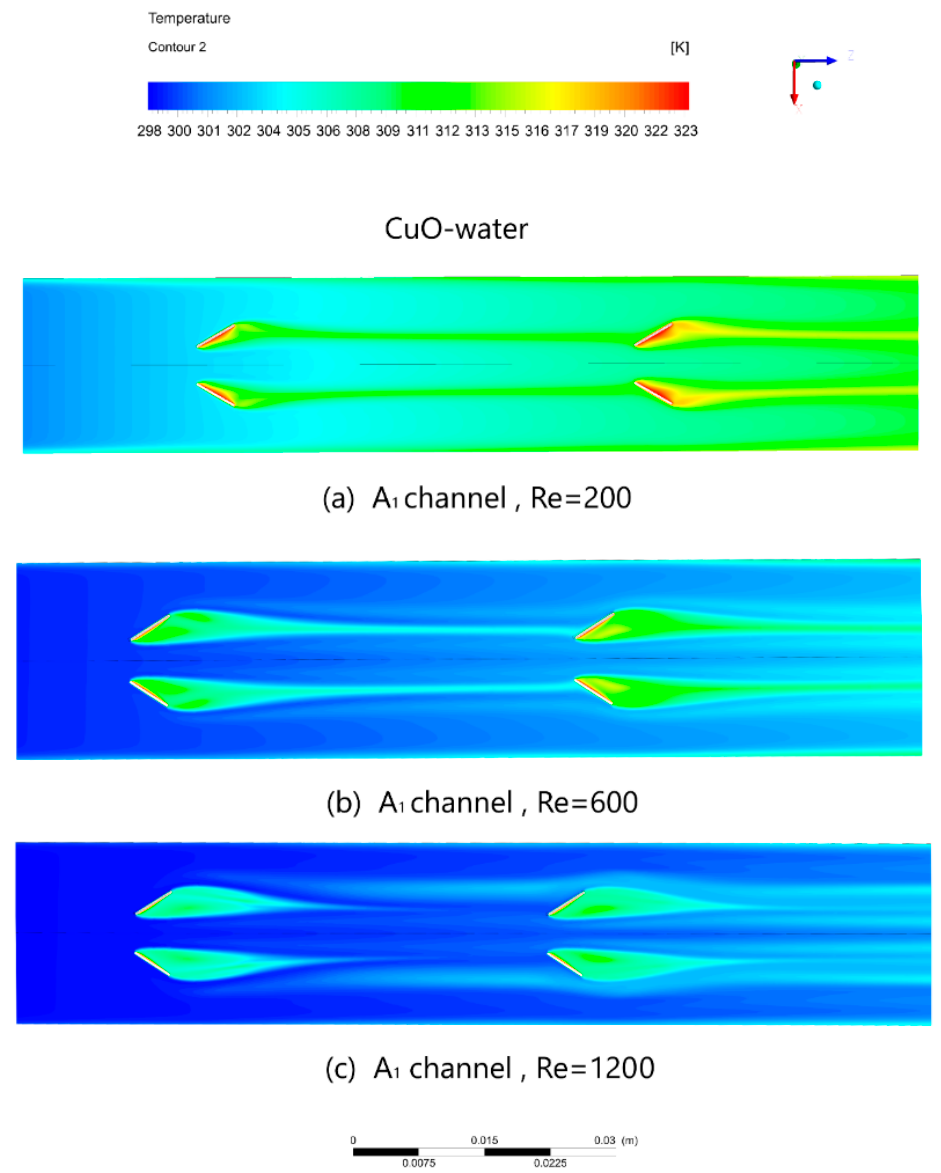
= 200, ( b ) Re = 600 and ( c ) Re =